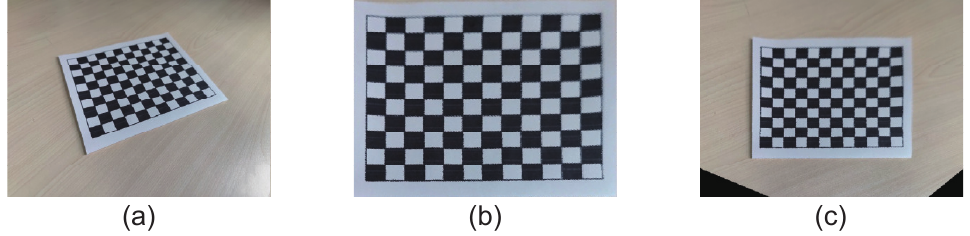
Figure 11. Correction of the image. ( a ) Is the original image, ( b ) is the corrected image when k h = k w = 0 and ( c ) is the corrected image when k h = k w = 0.2. (4) BEV